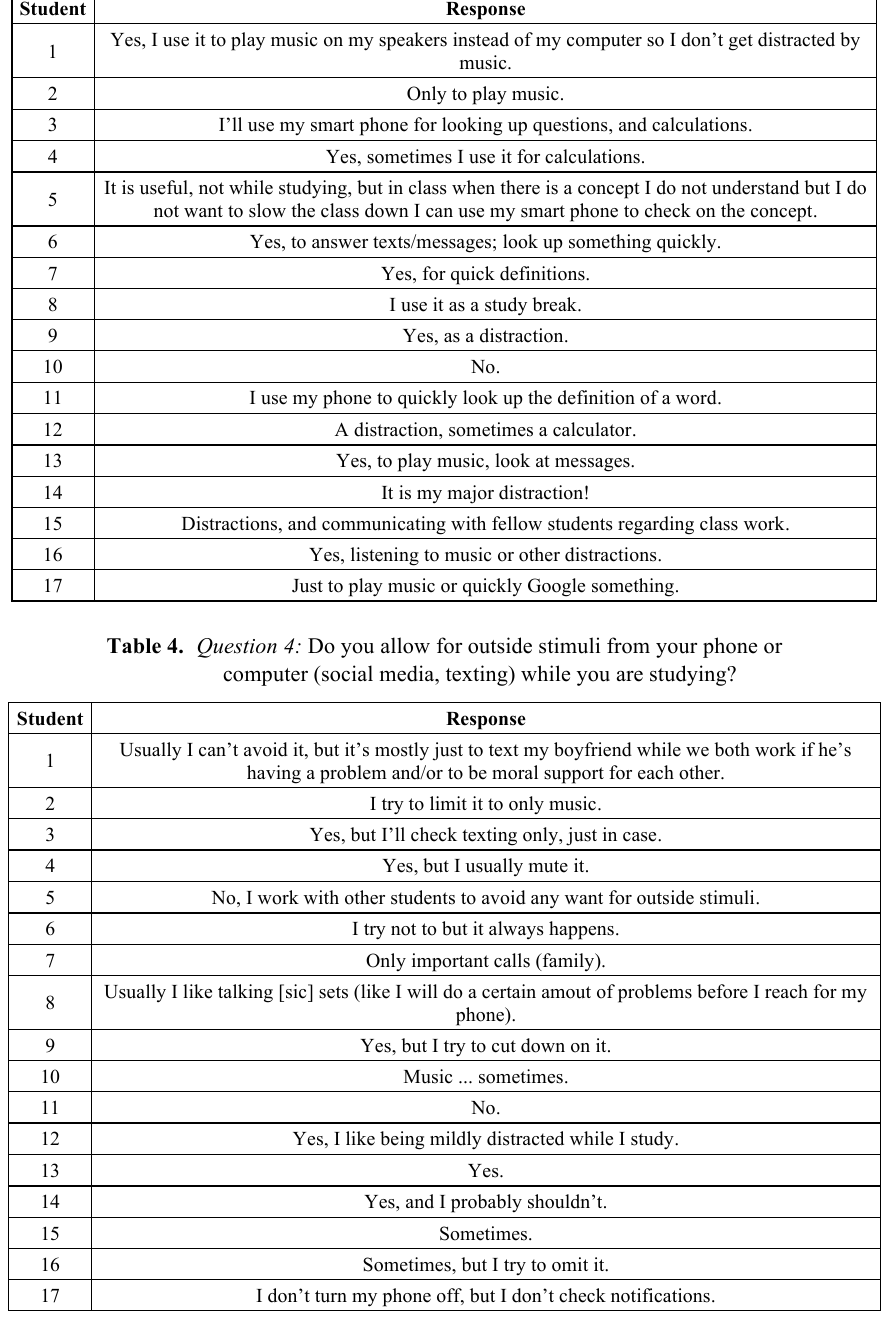
Table 3. Question 3: Does your smart phone play any role while you are studying? Student